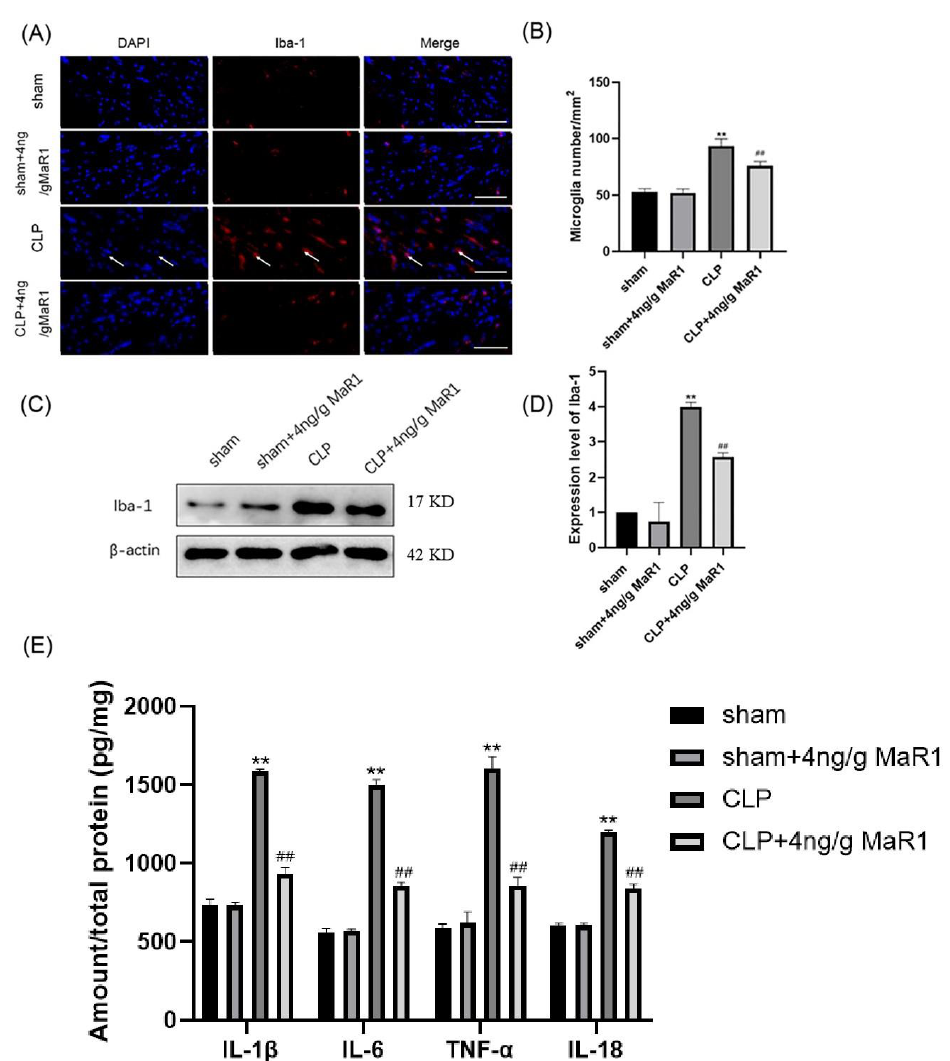
Figure 3. 4 ng/g MaR1 reduced microglia activation and pro-inflammatory cytokines in CLP rats: ( A , B ) immunofluorescence images of Iba-1 (red)/DAPI (blue) co-localization in hippocampal region of CLP rats and the quantitative analysis of immunofluorescence positive cells ( n = 5/group); after 4 ng/g MaR1 treatment, the number of Iba1 positive cells in the hippocampal CA1 region of CLP rats was significantly reduced; bar = 100 µ m; ( C , D ) representative immunoblotting bands detected by anti-Iba-1 and β -actin antibodies; grayscale values of the immunoblot bands were quantified ( n = 5/group); ( E ) levels of IL-6, IL-1 β , TNF- α , and IL-18 in the hippocampus determined by ELISA ( n = 4). Data are expressed as mean ± SD; ** p < 0.01, compared to the Sham group; ## p < 0.01, compared to the CLP